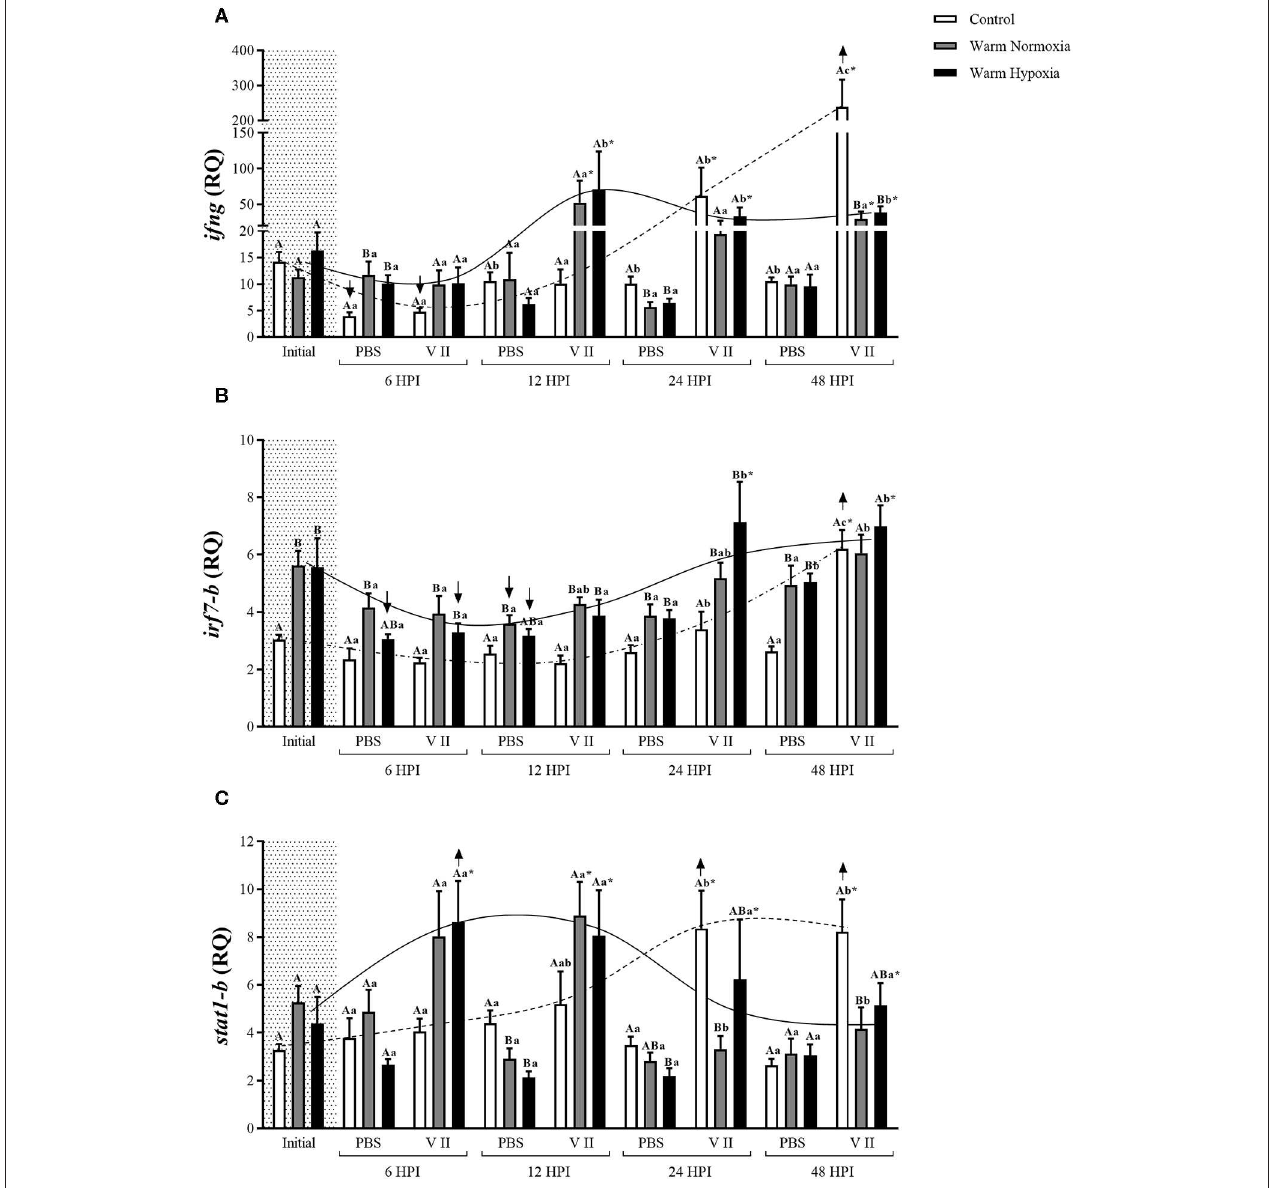
FIGURE 3 | Transcript expression levels of three anti-bacterial/anti-viral biomarkers [ ifng (A) , irf7-b (B) , and stat1-b (C) ] in the head kidney of salmon held at 12 ◦ C (under normoxia) or 20 ◦ C (under normoxia or mild hypoxia) (i.e., treatment) 6, 12, 24, and 48h post-intraperitoneal injection with PBS or Forte V II (i.e., injection group). Different capital letters indicate a significant difference ( P < 0.05) among treatments within an injection group at a given time point (e.g., the three treatments 6 HPI after PBS injection) whereas dissimilar lower case letters indicate a significant difference over time within a treatment/group combination (e.g., control PBS-injected fish at 6, 12, 24, and 48 HPI). An asterisk (*) indicates a significant difference between PBS and Forte V II injection groups within a treatment at the same time point post-injection. The arrows ( ↑ or ↓ ) indicate a significant difference compared with initial (constitutive expression) levels, within an injection group. Dotted (control) or solid lines (warm normoxia and hypoxia) illustrate the general pattern of changes in transcript expression levels for a given gene over time in Forte V II-injected fish, and are not based on any mathematical analysis. Transcript levels are presented as mean ± SE relative quantity (RQ) values (i.e., values for the transcript of interest were normalized to both etif3d and pabpc1 transcript levels and were calibrated to the individual with the lowest normalized expression level of that given transcript). N = 7–8.